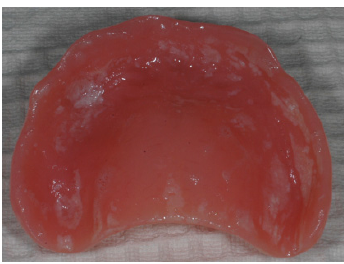
Figure 1. Biofilm on a denture belonging to a patient with poor oral hygiene routine. (photo: Marit